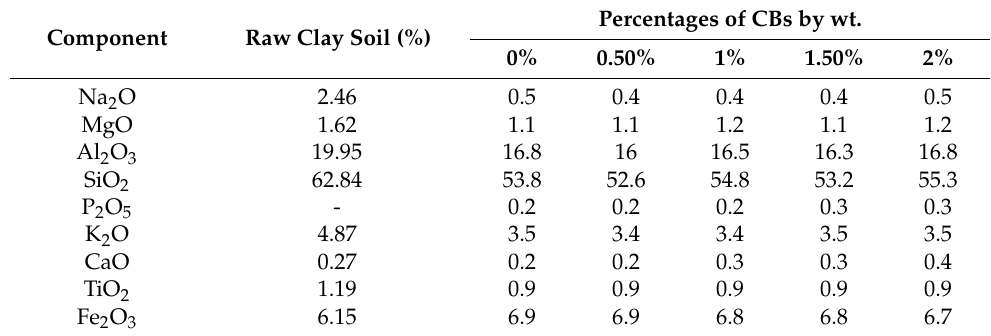
Table 2. Chemical composition of raw clay soil and brick samples incorporating CBs.